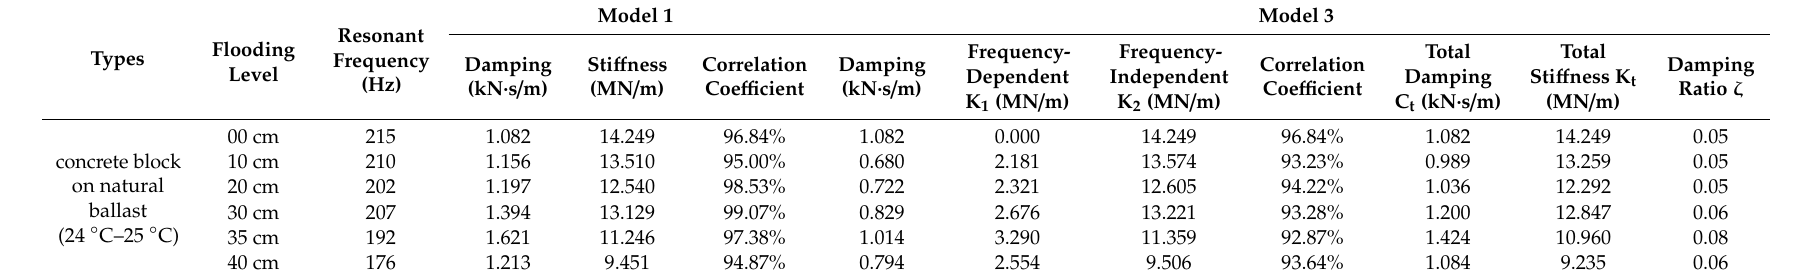
Table A2. Comparison of the dynamic properties of railway ballast in